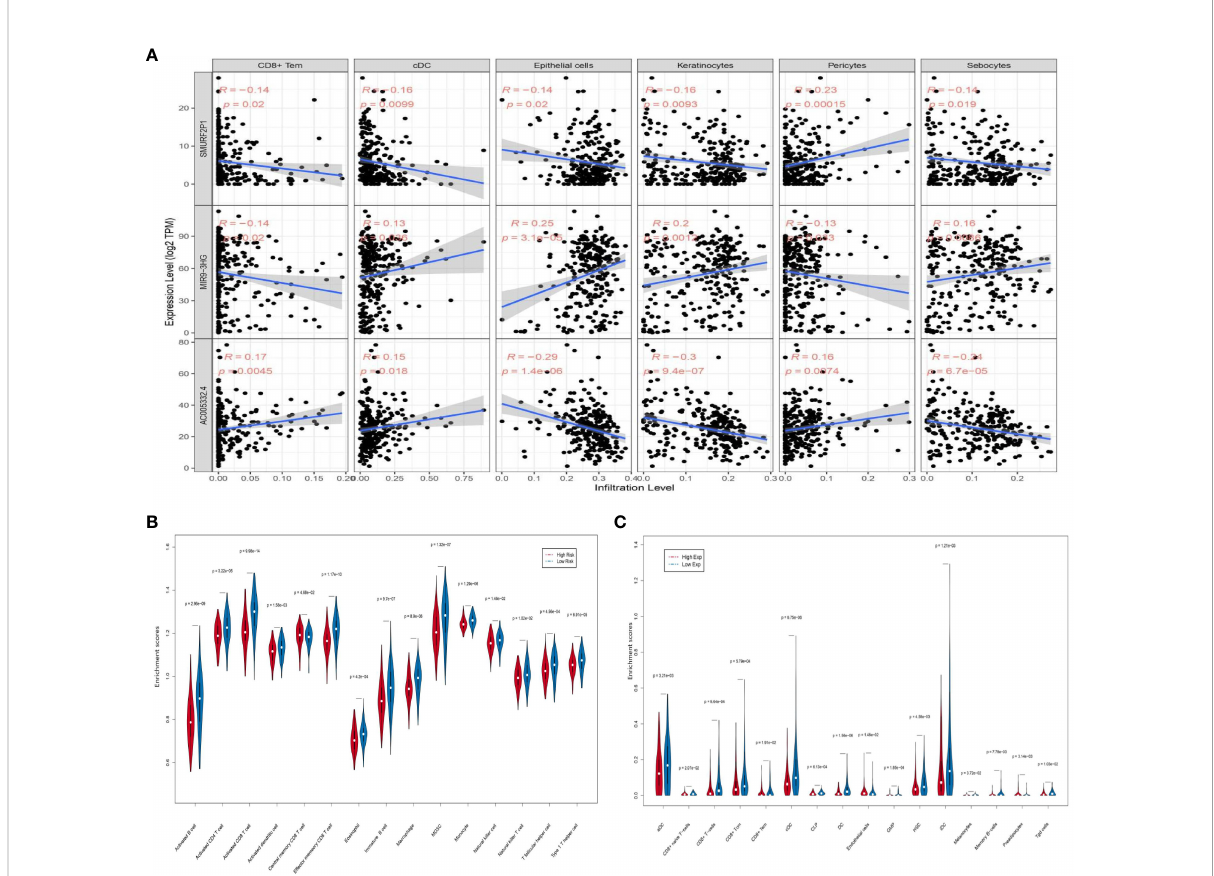
FIGURE 8 The association between the three prognostic ARLs and immune in fi ltration (xCell). (A) The pertinence between immune cell abundance in the relation to SMURF2P1 , MIR9-3HG , and AC005332.4 expression in CESC. (B) Violin plot which revealed that the immune cell types were differentially expressed in the two groups via ssGSEA. (C) Violin plot which revealed that the immune cell types were differentially expressed in the two groups via the xCell